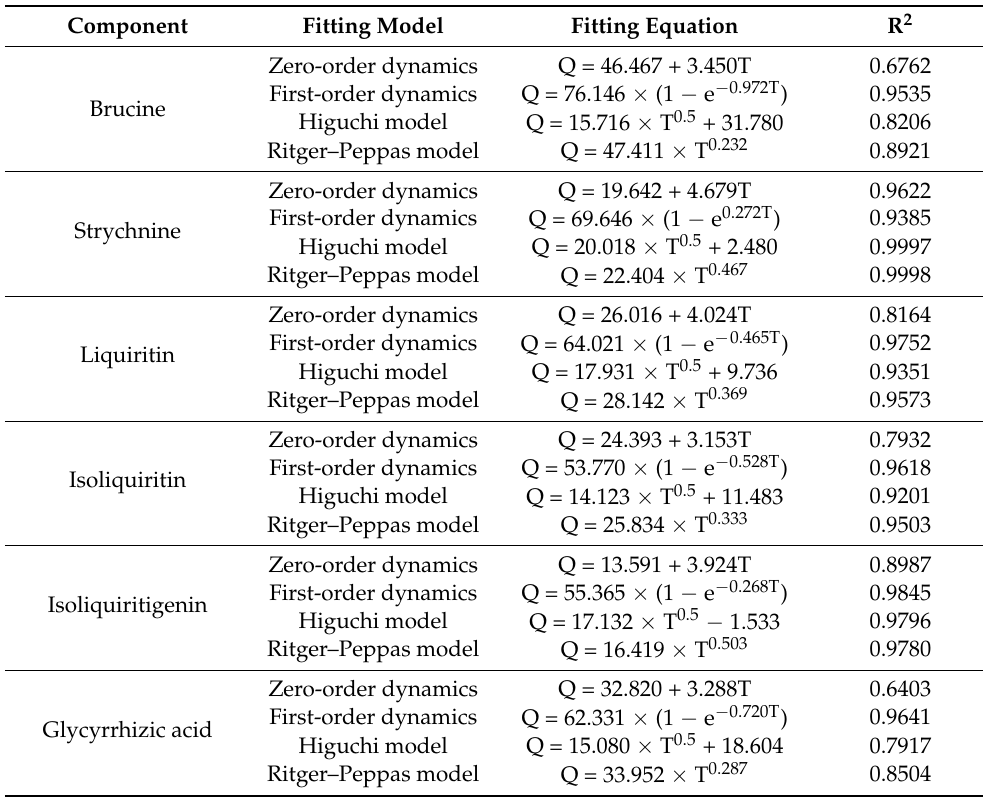
Table 9. Results of cumulative release fitting in artificial intestinal